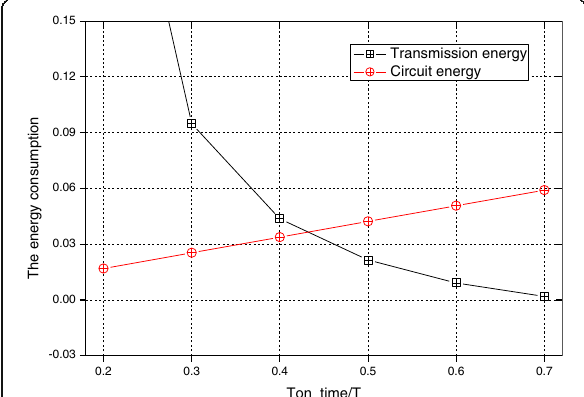
Fig. 7 The energy consumption of transmission and circuit at S